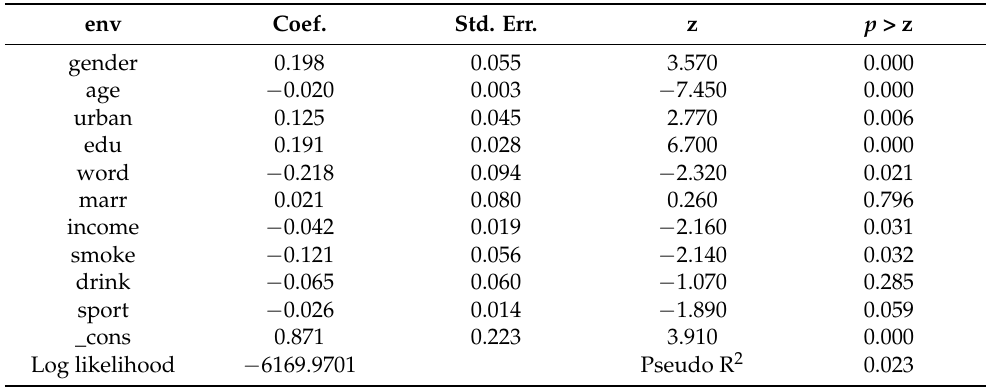
Table 7. Nearest neighbor matching results.